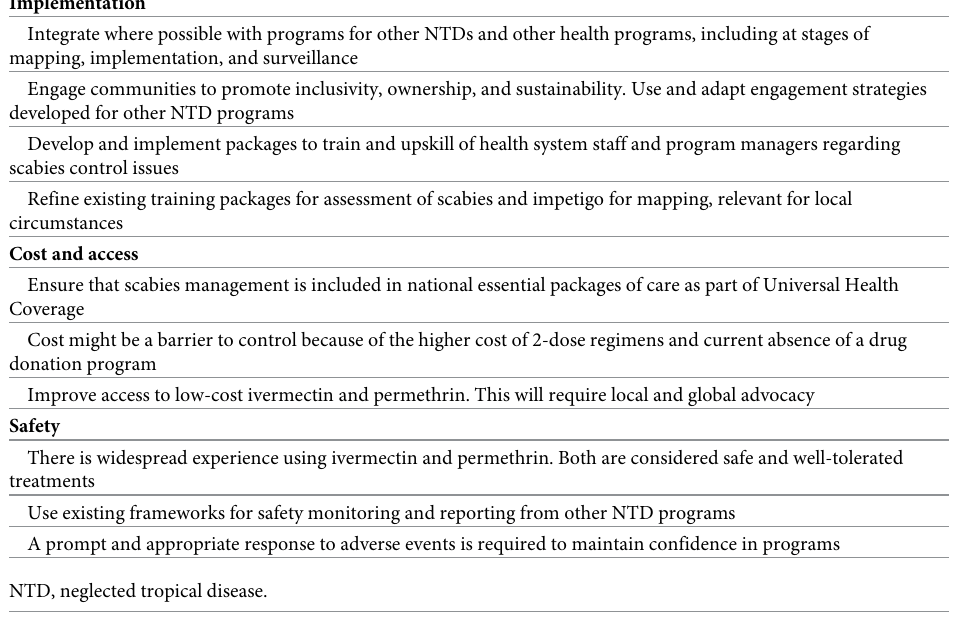
Table 2. Additional considerations for scabies control programs.